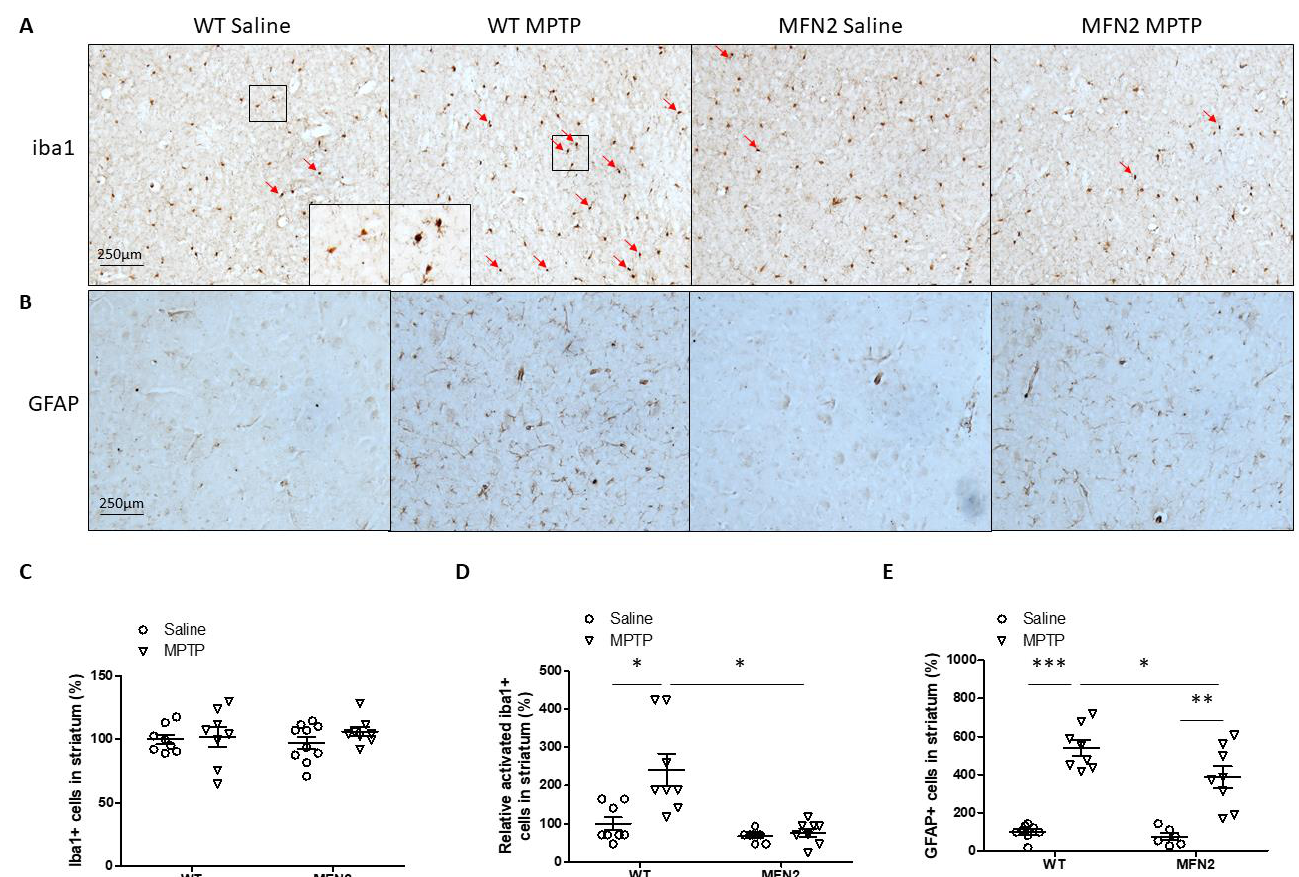
Figure 7. Mfn2 overexpression inhibited MPTP-induced inflammation in the striatum. Representative pictures of iba1 ( A ) staining in the striatum and quantification of total ( C ) or relative activated ( D ) microglia in the striatum are shown (Red arrows indicate activated microglia). Representative pictures of GFAP staining in the striatum ( B ) and quantification of astrocytes ( E ) in the striatum are shown ( n = 4; * p < 0.05, ** p < 0.01, and *** p < 0.001 compared to the control) .